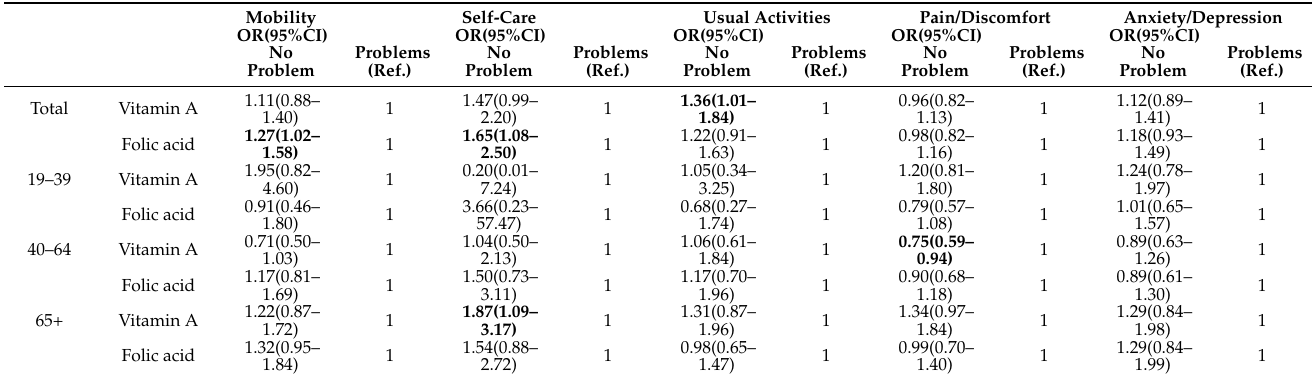
Table 3. Associations between vitamin A and folic acid and each of the five EQ-5D dimensions using multiple logistic regression